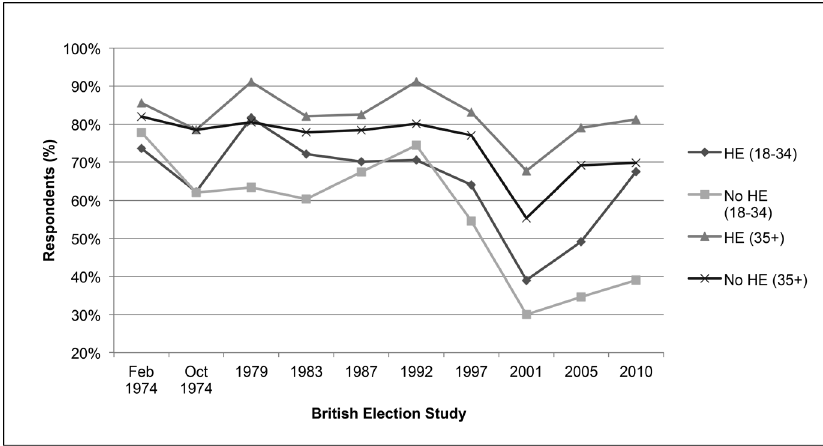
Figure 1: Absolute turnout at UK General Elections by age and HE experience, Feb 1974 to 2010. Source: British Election Studies Feb 1974 to 2010, n ranging from 1,874 to